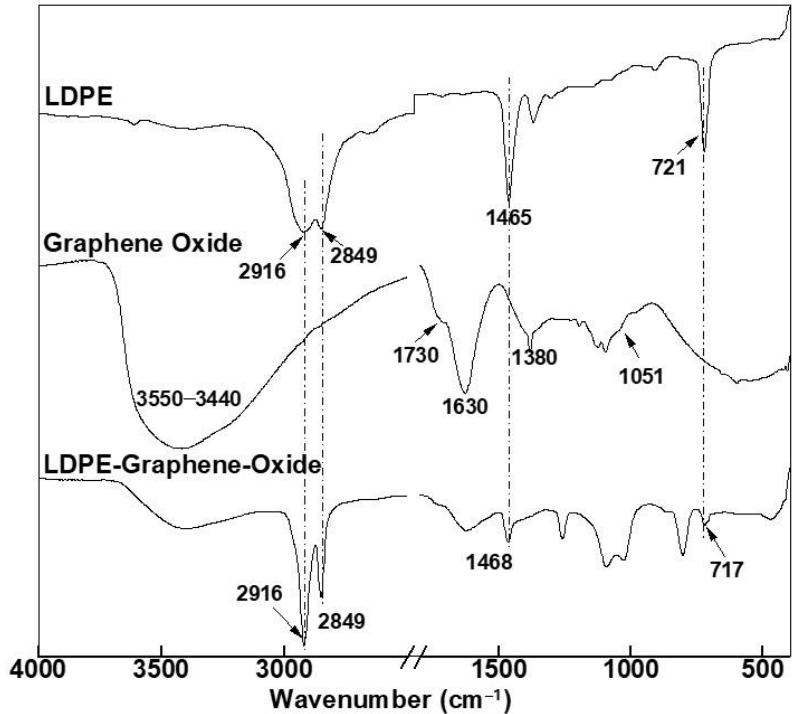
Figure 6 . FTIR spectrum of pure GO, pure LDPE, and LDPE-GO. Figure 6. FTIR spectrum of pure GO, pure LDPE, and